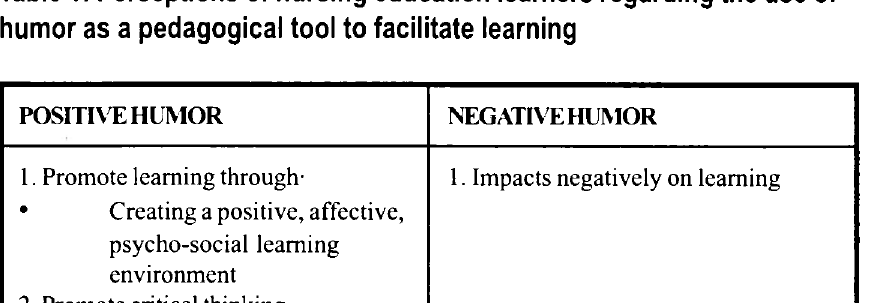
Table 1: Perceptions of nursing education learners regarding the use